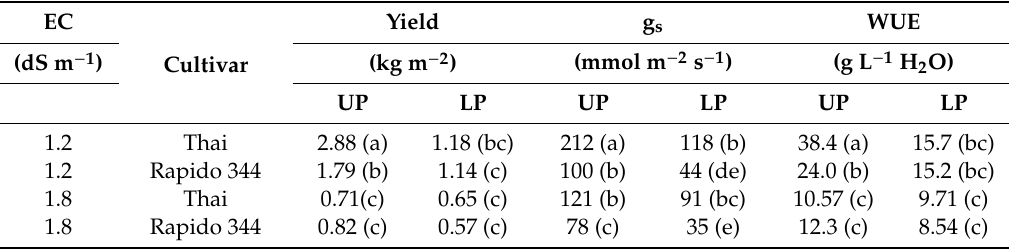
Table 6. Results from experiment 4 (CDZ-Myanmar). E ff ects of factorial combination of EC of